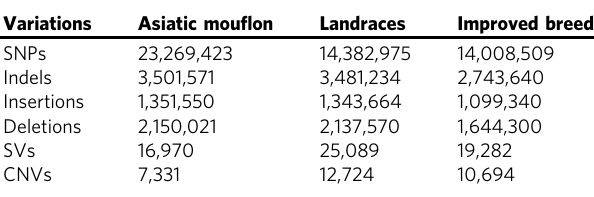
Table 1 Summary information of whole-genome